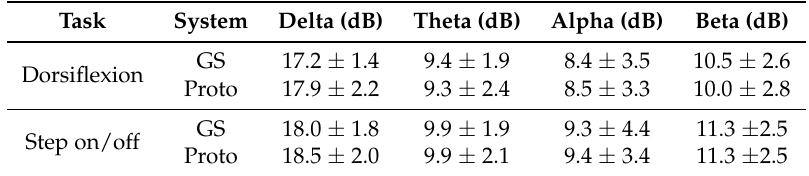
Table 2. Means and standard deviation for power values in decibels (dB) across four EEG bands in dorsiflexion and step